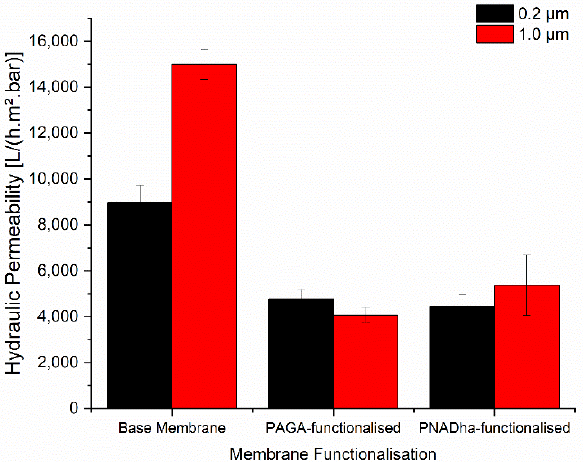
Figure 2. Changes in hydraulic permeability for track etched membranes upon grafting of polyelec- trolytes.